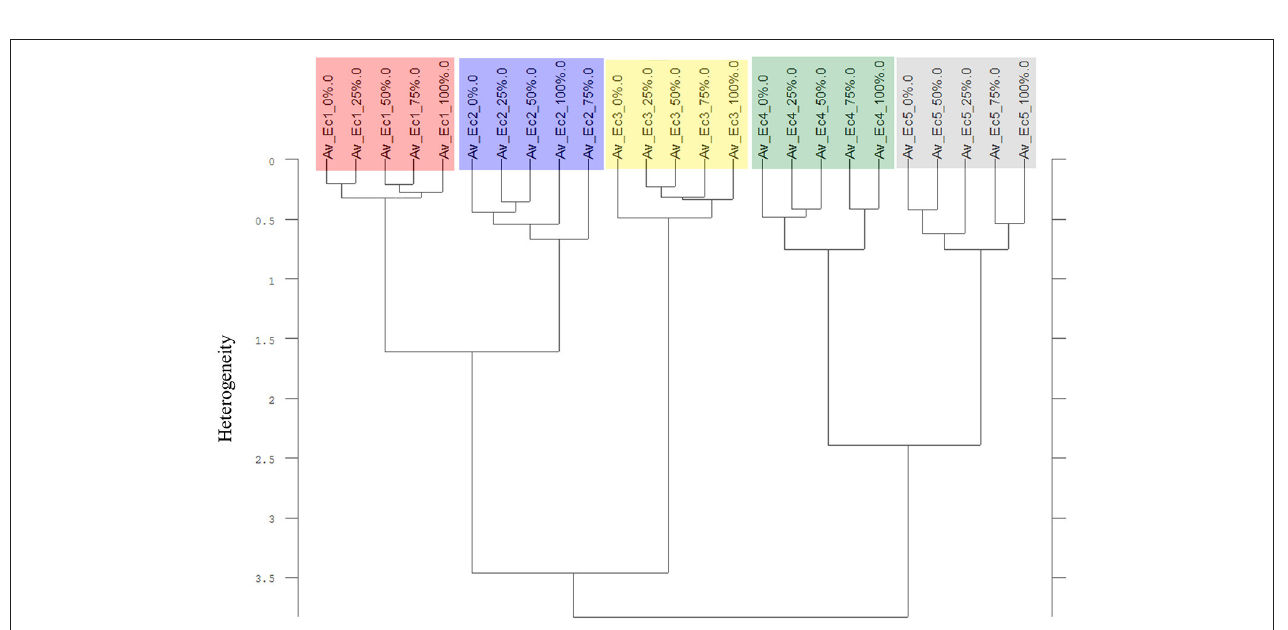
FIGURE 11 | Cluster analysis of the Av-spectra of all proveniences of the species Echinochloa crus-galli (Ec, barnyard grass) for the experiment 2-2. Complete frequency range (3,997–374 cm − 1 ) of the Av-spectra was evaluated with the second derivation and vector normalization, Ward’s algorithm und Euclidian distance. The Av-spectra are averages (Av) of FTIR-ATR spectra of the different root segments (100% root tip, 0% root basis etc.; see Figure 1 for scheme, Table 2 for n, Table 1 for names of cultivars and proveniences).